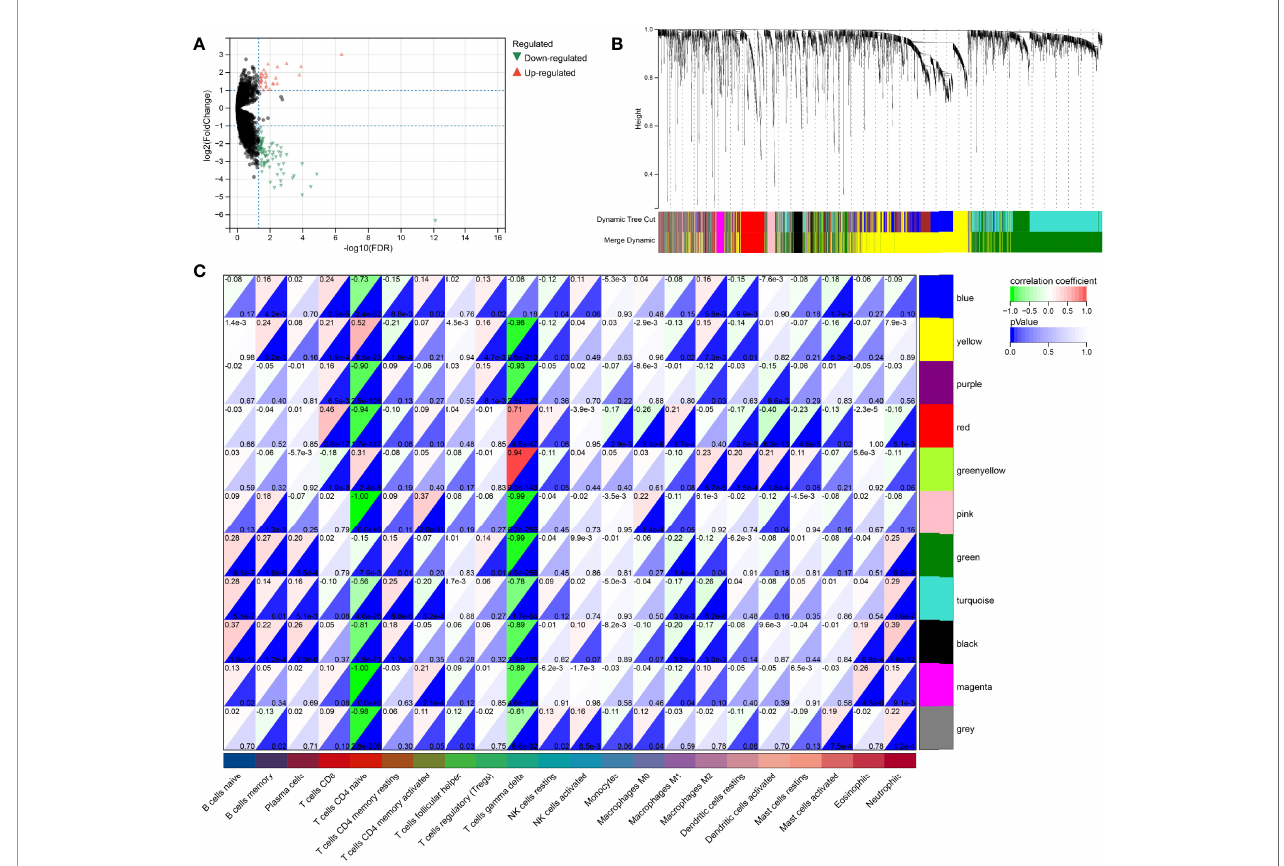
FIGURE 4 | WGCNA analysis for DeRNA. (A) Volcano plot of DeRNA. (B) Clustering results of minded modules in DeRNA dataset. (C) The correlation between different modules and the proportions of 22 immune